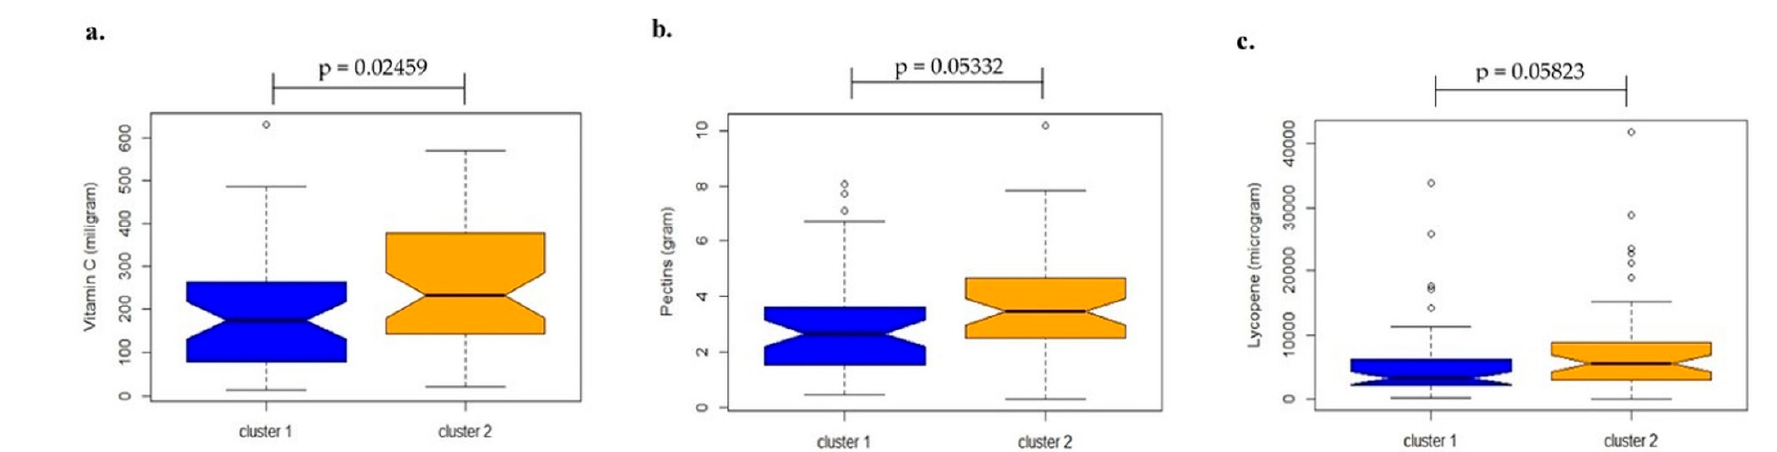
Figure 3. Distribution of nutrients intake from pregnancy, by clusters identified in human milk samples. Vitamin C ( a ), pectins ( b ), and lycopene ( c ) intake estimated by a quantitative food frequency questionnaire (QFFQ) for pregnancy, in each cluster. Legend: The box-plot is representing the interquartile range (IQR) and the line inside represents the median. Small circles denote outliers. Mann-Whitney test was performed to compare the values between the clusters.